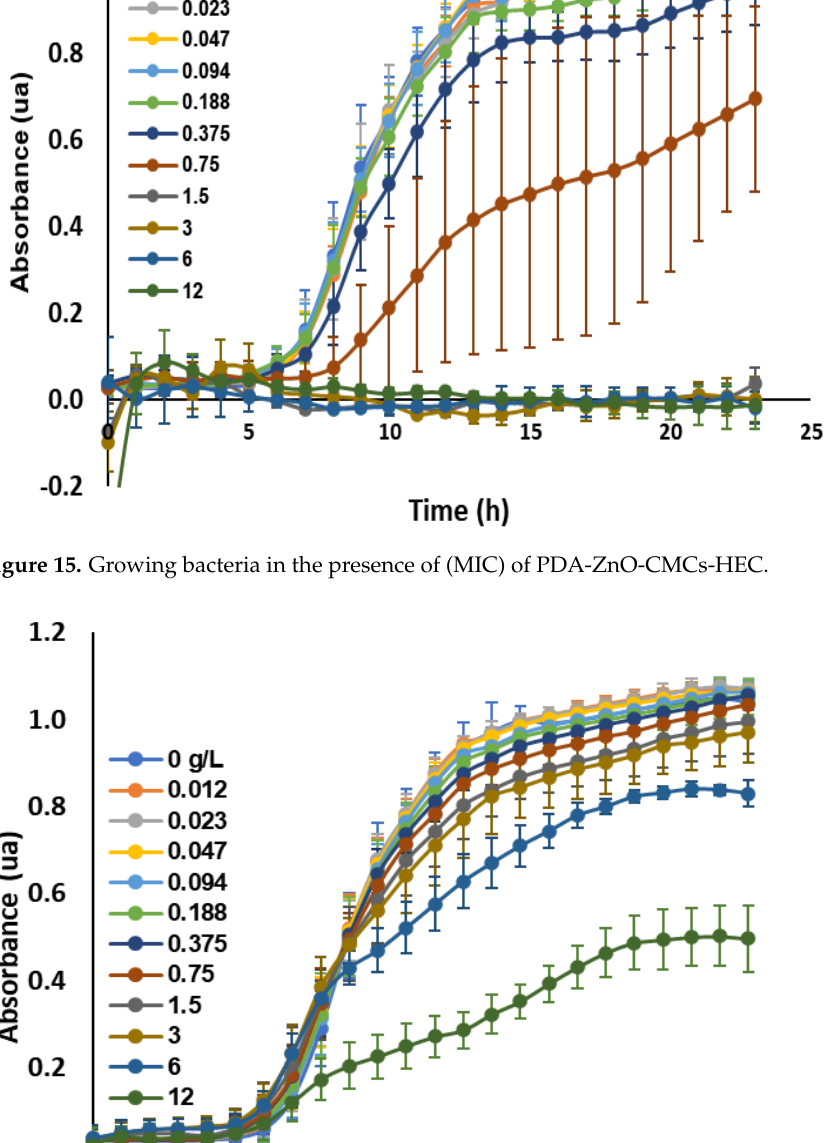
Figure 17. Mechanism of antimicrobial activity of hydrogels against E. coli. 6. Conclusions We rationally combined PDA-ZnO nanosheets as a stimuli-responsive matrix into CMCs-HEC hydrogel to obtain a pH- and thermal-responsive PDA-ZnO-CMCs-HEC hy- drogel with inhibitory activity against E. coli . The swelling capacity of the hydrogels was pH dependent as it had a higher swelling capacity in acidic pH as compared to basic pH, though the presence of PDA-ZnO within the hydrogel imparted a colorimetric response triggered by a change in pH from acidic to basic pH. This response resulted in a colour transition from purple to pale pink visible to the naked eye and as such, it is hypothesized that this property can be utilized as a sensing mechanism to indicate the onset of infection in a wound. Moreover, the incorporation of ZnO within the hydrogel ensured that the composite had inhibitory activity against E. coli as compared to the composite without nanoparticles.